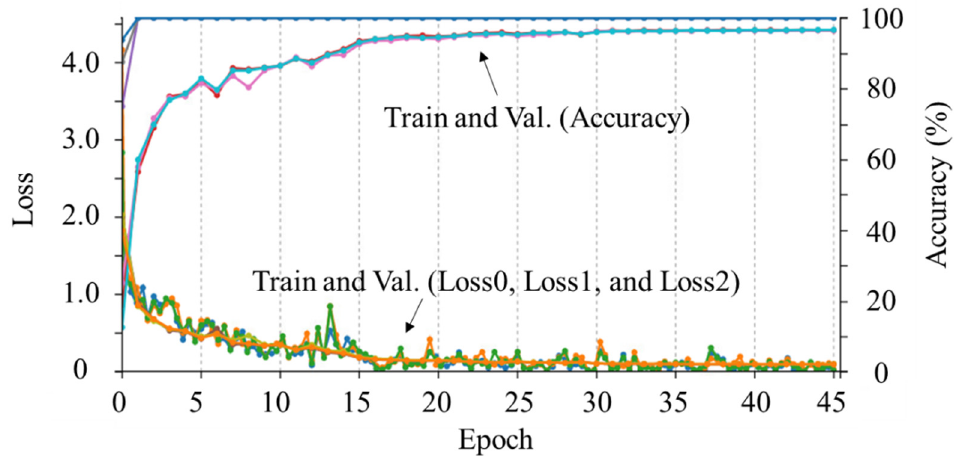
Figure A6. Epoch vs. loss and accuracy for W0.9 δ for GoogLeNet.